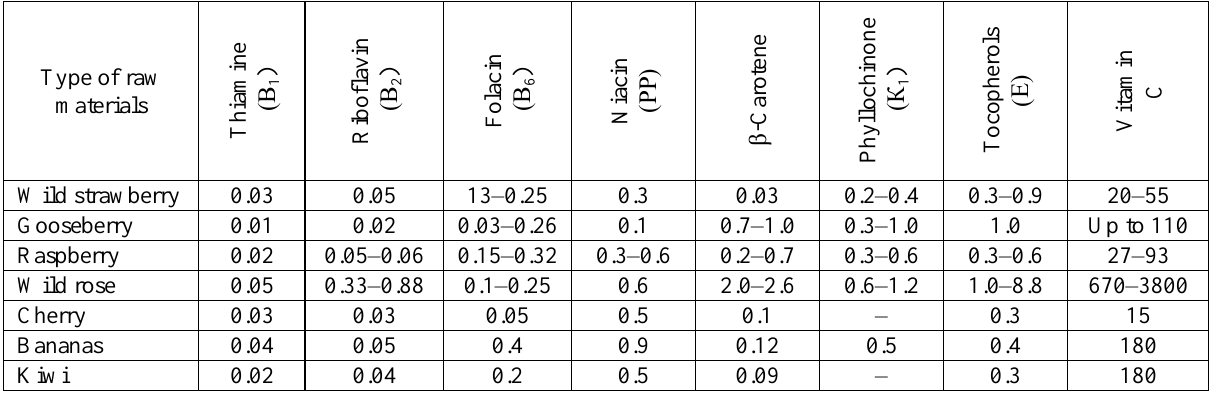
Table 4. Content of the most important minerals in the composition of fruits and berries, mg/kg